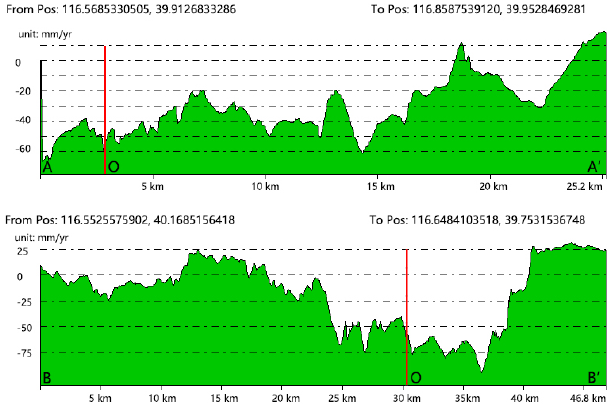
Figure 3. Subsidence rates along profile A–A (cid:48) and profile B–B (cid:48) shown in Fig. 2. The profiles intersect at the point O. (Note: negative values indicate